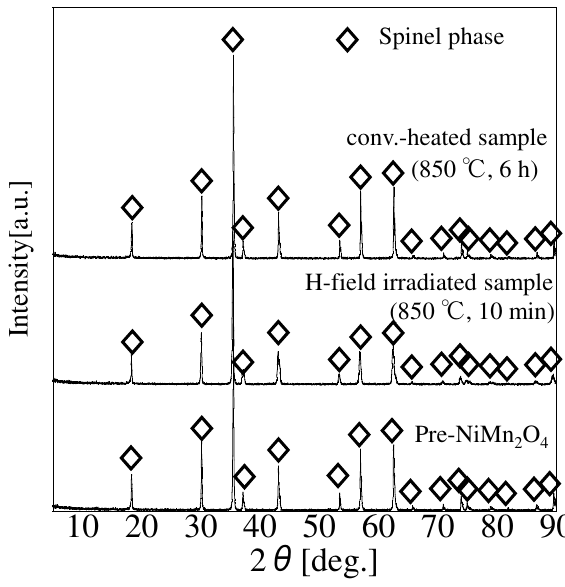
Figure 2. X-ray diffraction (XRD) patterns of synthesized NiMn 2 O 4